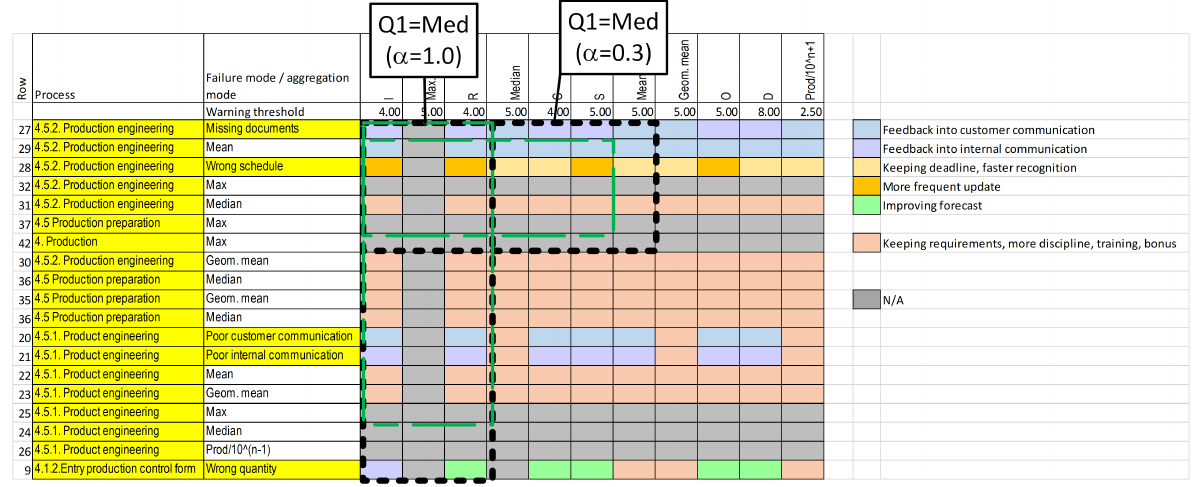
Figure 7. The matrix of corrective/preventive actions for α = 0.3 and α =